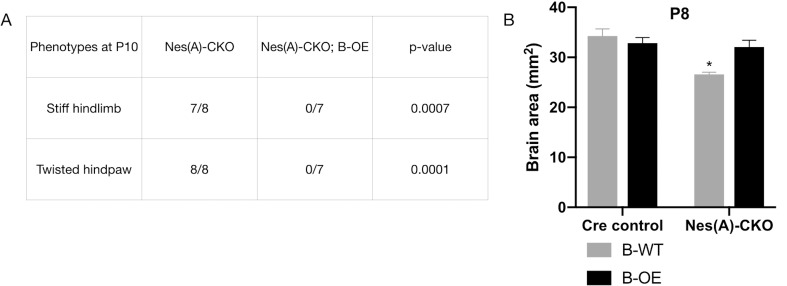
TorsinB overexpression prevents overtly abnormal postures and gross disruption of brain morphology in N-CKO mice.(A) Table of overtly abnormal postural phenotypes displayed by N(A)-CKO and N(A)-CKO;B-OE mice at P10. TorsinB overexpression eliminates these phenotypes that are prevalent in N(A)-CKO mice (stiff hindlimb: Chi square test χ2 = 11.48, p=0.0007; twisted hindpaw: Chi square test χ2 = 15, p=0.0001). (B) Brain area measurements of P8 Nestin-Cre control, Cre control;B-OE, N(A)-CKO, and N(A)-CKO;B-OE. TorsinB overexpression prevents the reduction in brain size characteristic of N(A)-CKO mice (two-way ANOVA main effect of genotype F1, 8 = 13.54, p=0.0062, main effect of torsinB level F1, 8 = 3.103, p=0.1162, interaction F1,8 = 8.916, p=0.0174; asterisks denote the following p-values from Tukey’s multiple comparisons tests: *=p < 0.05; Cre control n = 3, Cre control;B-OE n = 3; N(A)-CKO n = 3, N(A)-CKO;B-OE n = 3).Figure 3—figure supplement 3—source data 1.Behavioral and brain morphological characterization of Nes(A)-CKO;B-OE mice.